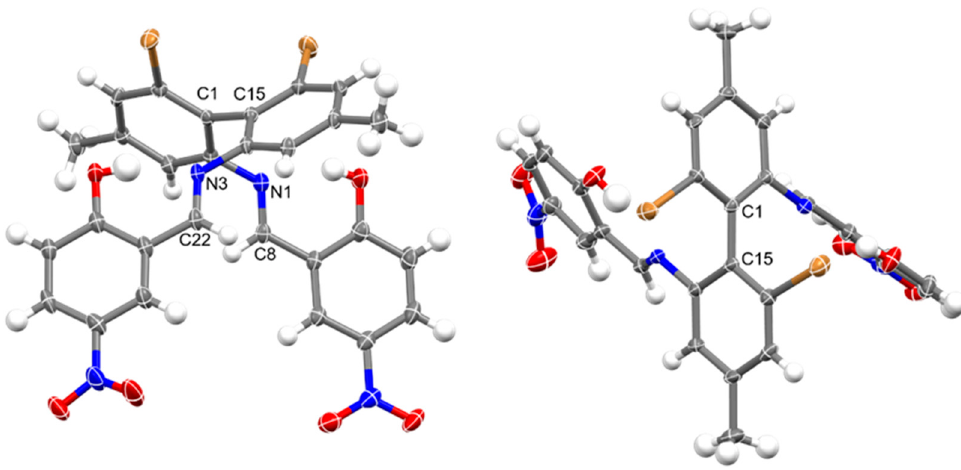
Figure 1. Molecular structure of ZH4 determined by X-ray diffraction at 100 K. White: H, gray: C, blue: N, red: O, and orange: Br.